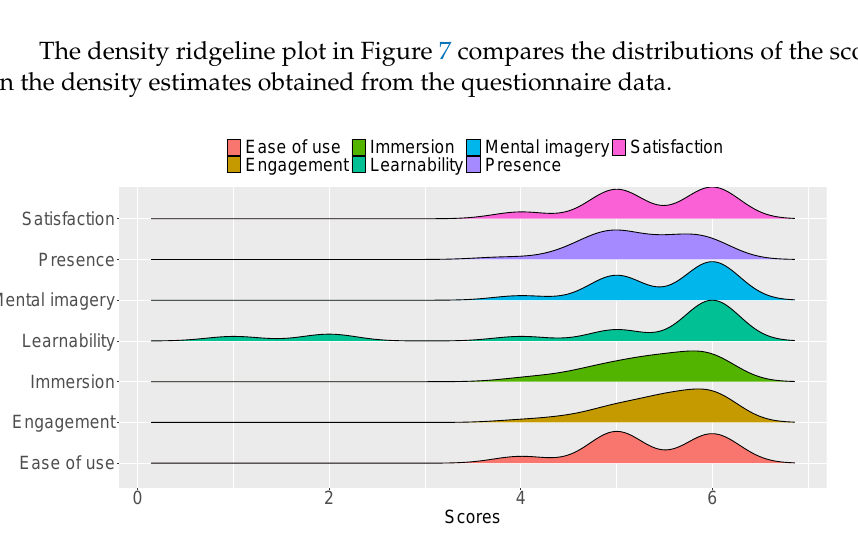
Figure 7. Distributions of the scores of the user experience